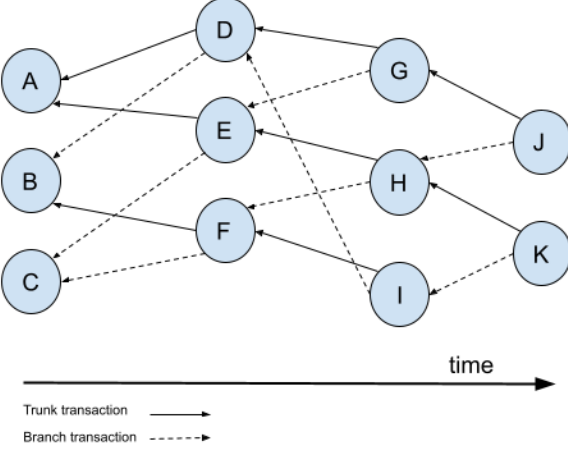
Figure 2. Ideal IOTA tangle